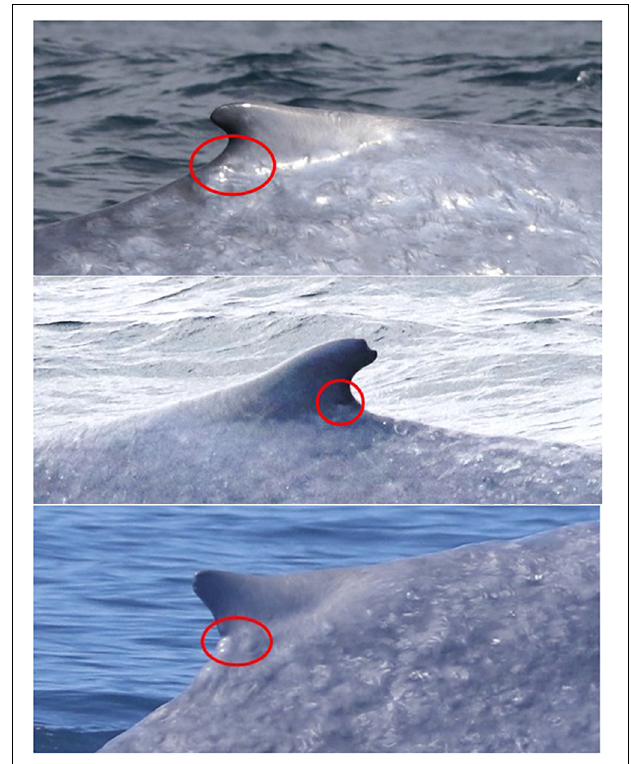
FIGURE 6 | Example photographs of a blisters on the dorsal fins of three different blue